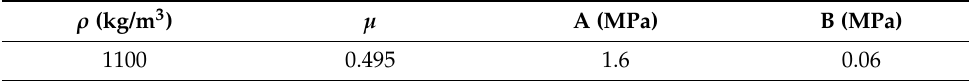
Table 2. Mechanical parameters of the PU adhesive layer.